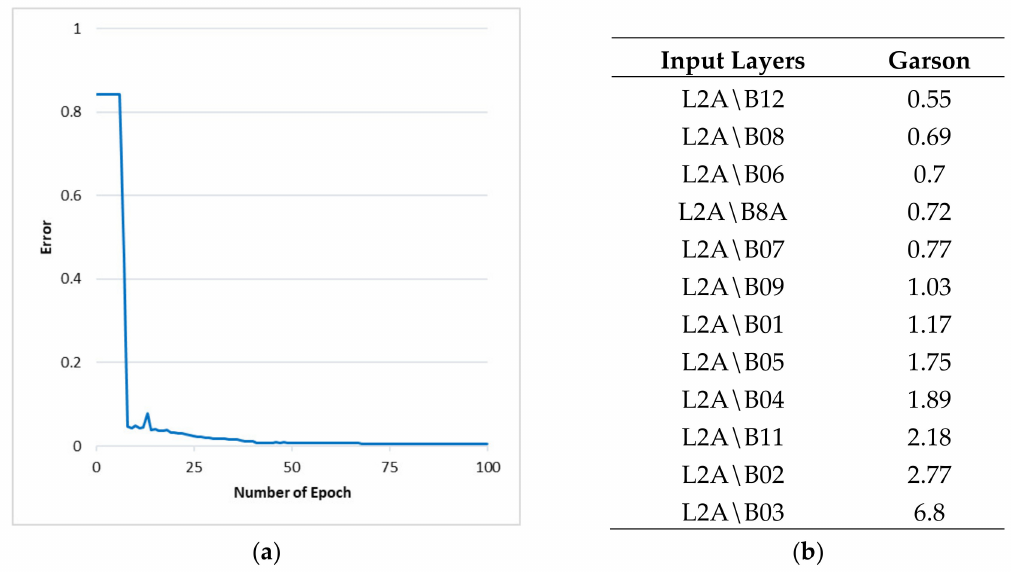
Figure 15. ( a ) Plot of MSE and ( b ) weight parameters for the MLP based on Sentinel-2 Level-2A BOA products.